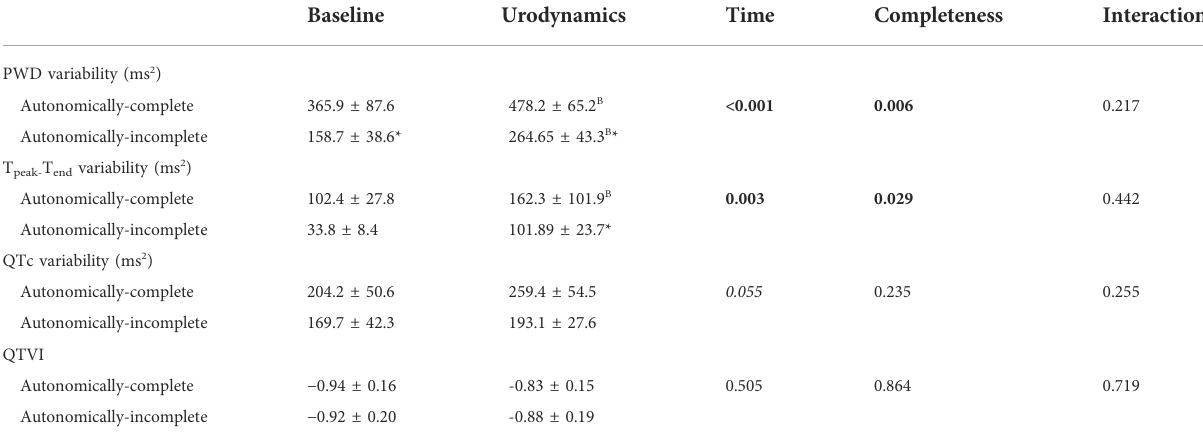
TABLE 3 ECG markers for risk of cardiac arrhythmia at baseline and during urodynamics